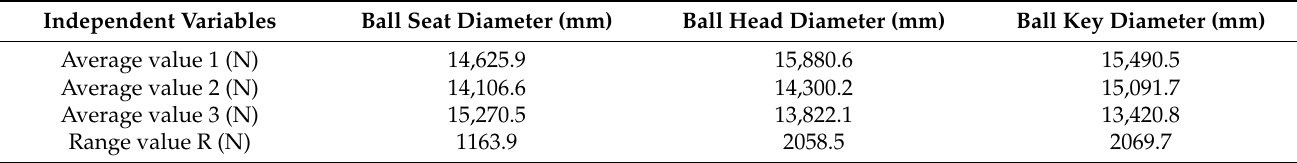
Table 4. Range of values for the average ball key contact